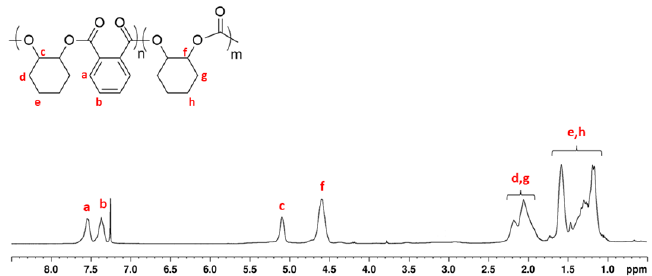
Figure 3. 1 H NMR spectrum (400 MHz, CDCl 3 and 298 K) of poly(cyclohexene phthalate-block-cy- clohexene carbonate) obtained from a mixture of PA, CHO, and CO 2 (entry 2 in Table 3).